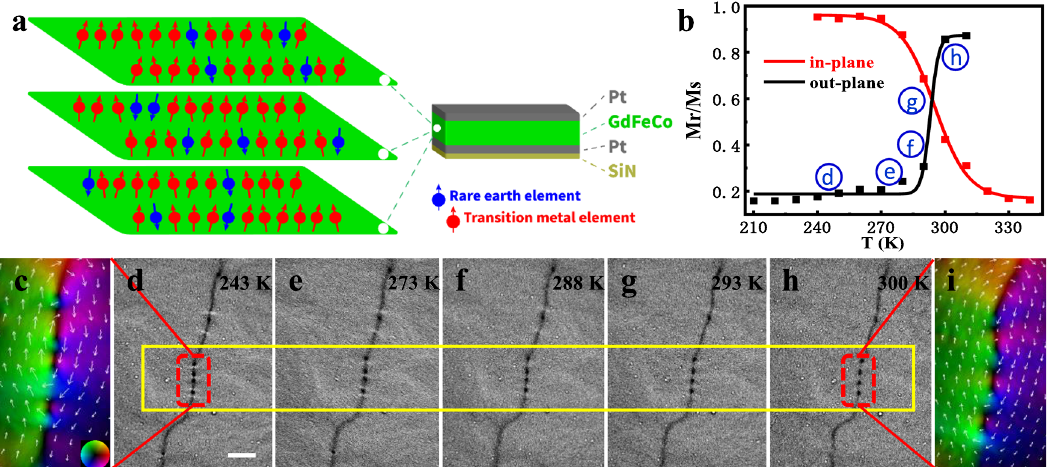
Fig. 1 The magnetic domain evolution in amorphous ferrimagnetic GdFeCo fi lm. a Schematic illustration of the layer structure. b The temperature dependence of the reduced remnant magnetization acquired from M – H measurements in Gd 15 + x (Fe 94 Co 6 ) 85 − x ( x = 0.2), showing the SRT between in- plane and out-of-plane magnetization at about 290 K. c The lateral magnetic component distributions deduced from the selected domain wall region at 243 K by using the transport-of-intensity equation (TIE) analysis. The color wheel for the direction of in-plane magnetization is displayed in the inset. d – h Over-focus L-TEM images at different temperatures showing the corresponding domain wall evolution with increasing temperature. i The magni fi ed lateral magnetic component distributions by TIE demonstrating the decreasing of the in-plane magnetization beside the domain wall at 300 K. The scale bar is 2 μ